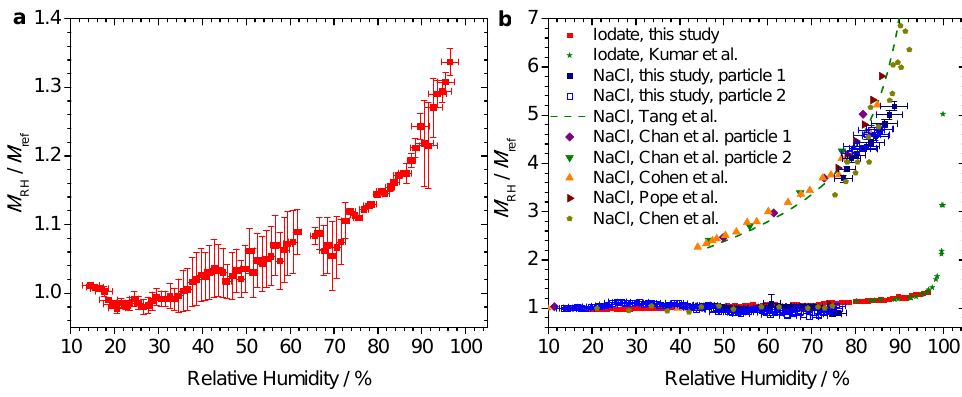
Fig. 8. Relative change in mass (GF = mass growth factor = M RH / M ref ) of droplets suspended in the electrodynamic balance on varying RH. (a) The relative change in mass of iodic acid solution droplets measured using the EDB, where M ref was chosen as an average of points below 20% RH. Note that even at low RH, iodic acid droplets contain a significant amount of water; see Fig. 9. (b) The same iodic acid data is plotted (also in red) and compared with the growth of sodium chloride. Our measurements of NaCl hygroscopic growth are compared to literature data (Chan et al., 1997; Cohen et al., 1987; Pope et al., 2010; Chen et al., 2003; Tang et al., 1997). In addition we plot the GF corresponding to water activity literature data for bulk iodic acid solutions of known concentration in green circles (Kumar et al., 2010); the translation from concentration ( C) in wt% of solute to growth factor here requires some explanation. In order to translate concentration into GF we need to relate the data at an RH where the composition is well known. We chose a point close to the deliquescence point where we are confident that the solution is in equilibrium with the surrounding vapour, rather than at a low RH where the iodic acid droplets become ultra-viscous or glassy (see discussion in text). Hence, GF RH = GF ∗ C ∗ / C RH and we chose 83.8% as RH ∗ at which RH the EDB gives a GF ∗ of 1.16. According to Kumar et al. (2010) the corresponding C ∗ is 75.32wt%, which then allows us to translate Kumar et al.’s data into GF (green